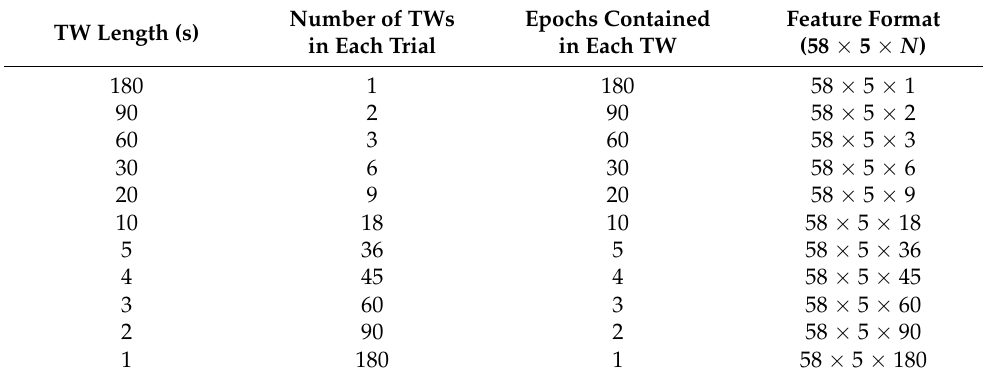
Table 2. The detailed information of TW lengths in each trial. N is the number of calculated features in each trial for frequency band of a selected channel.